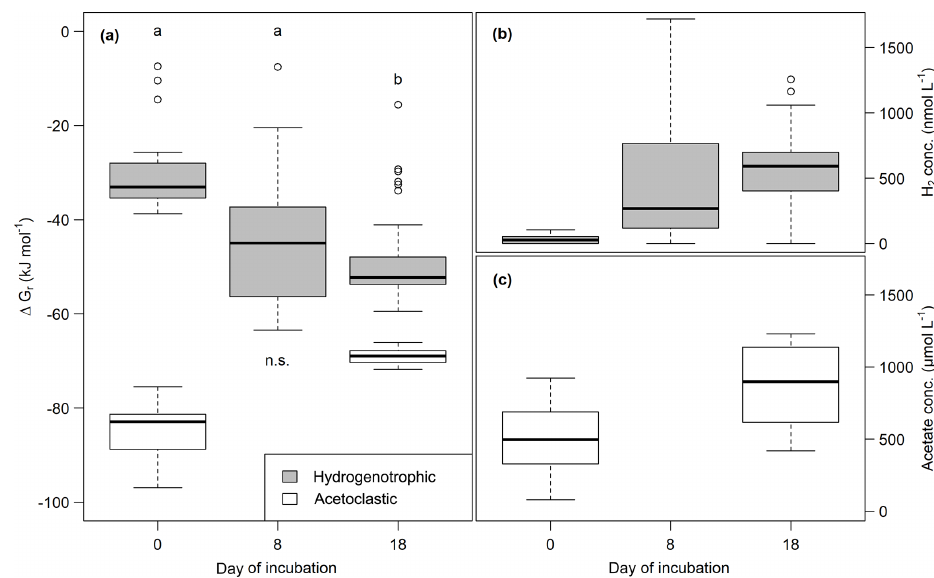
Figure 6. (a) Change of Gibbs free energy of hydrogenotrophic (gray) and acetoclastic (white) methanogenesis and of H 2 (b) and acetate (c) concentrations over time. More negative (cid:49)G r values correspond to a higher energy yield. Different lowercase letters denote significant differences between sampling